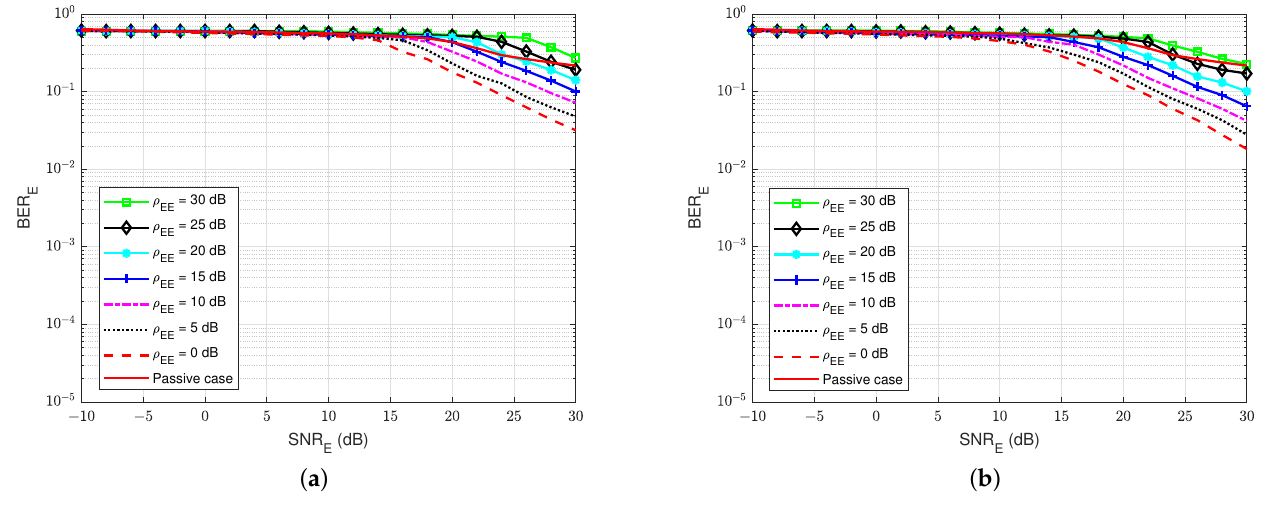
Figure 20. BER E versus SNR E , ρ EE = 30 dB in case of an active eavesdropper: ( a ) Blind without feedback; ( b ) Semi-blind without feedback.